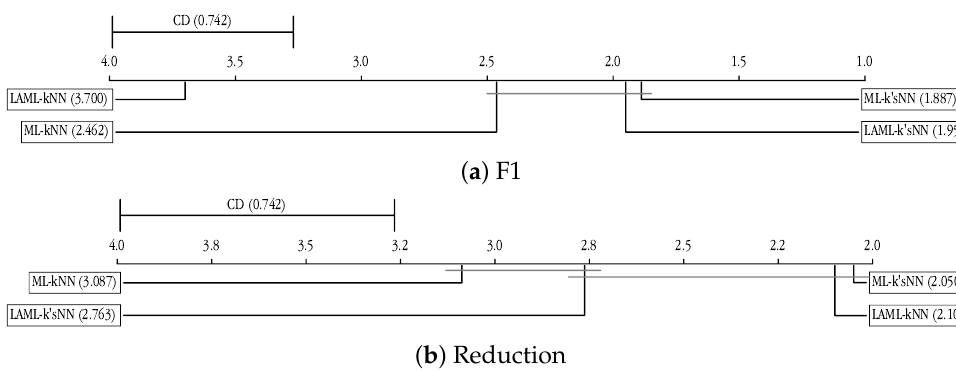
Figure 12. Nemenyi test results from the different methods, measuring reduction and F1 metric.